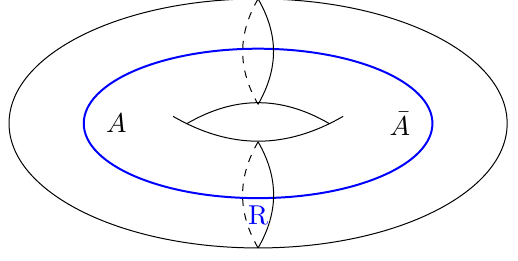
Figure 26 . Separated solid torus with a Wilson loop operator